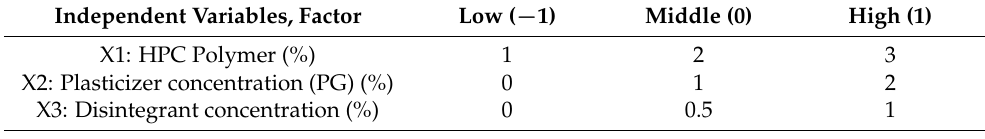
Table 2. Variables in Box-Behnken design for FLBFDOFs.